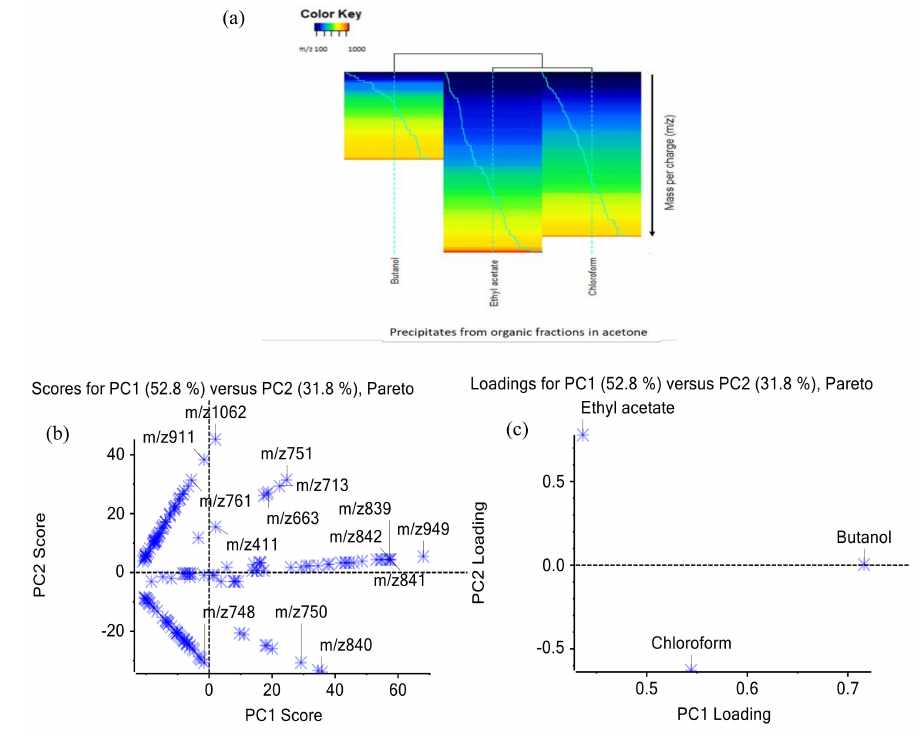
Figure 6. Heat mapping ( a ) and principal component analysis with score ( b ) and loading ( c )